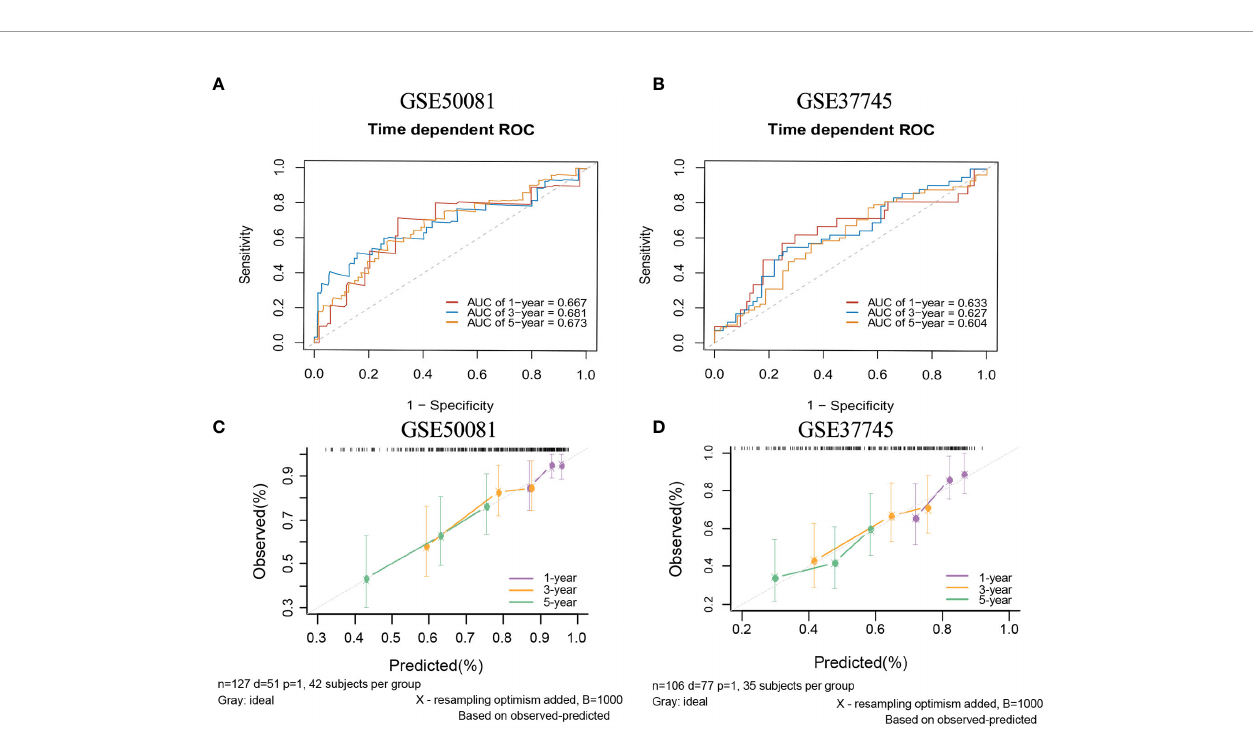
FIGURE 12 | The ROC curves and calibration plots of comprehensive model in external validation data sets.1-,3-,5-year ROC curves: (A) GSE50081 dataset and (B) GSE37745 dataset. The calibration plots: (C) GSE50081 dataset and (D) GSE37745